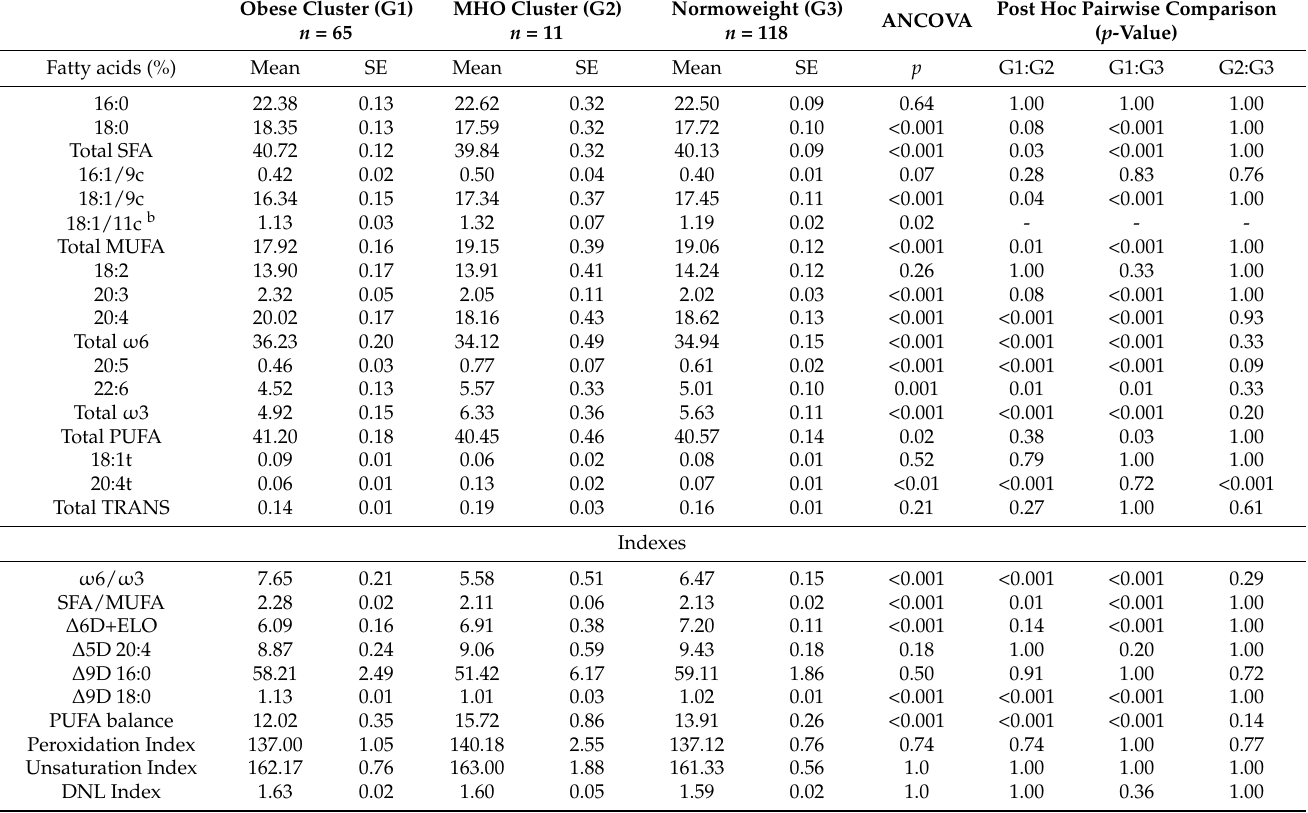
Table 2. Red blood cell (RBC) membrane fatty acid